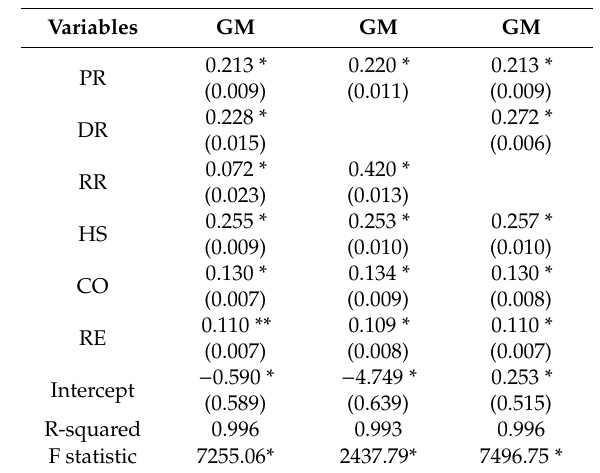
Table 5. Numerical score of GM regressed on six category numerical score rankings.